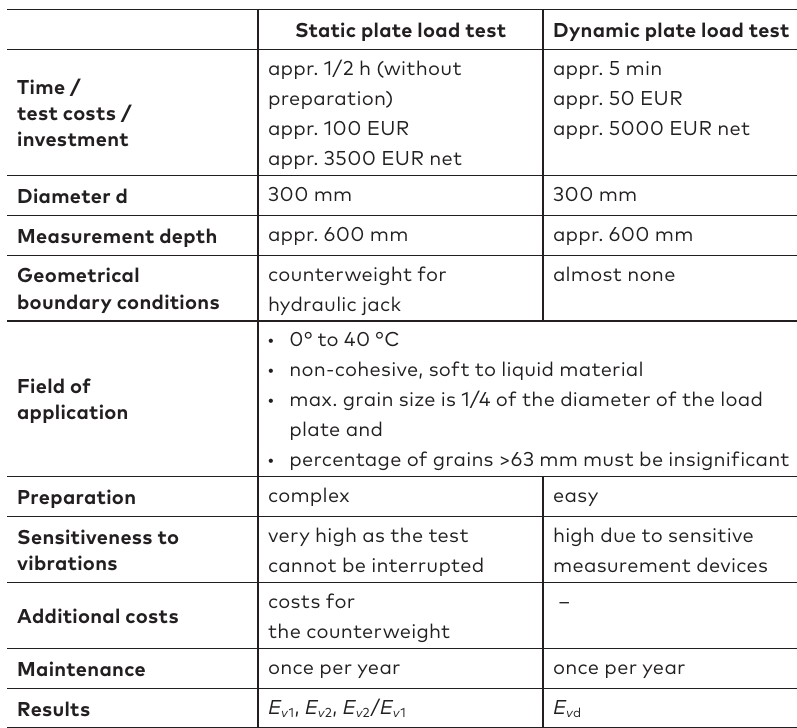
Table 1. Parameters and resources required for performing the static and dynamic plate load